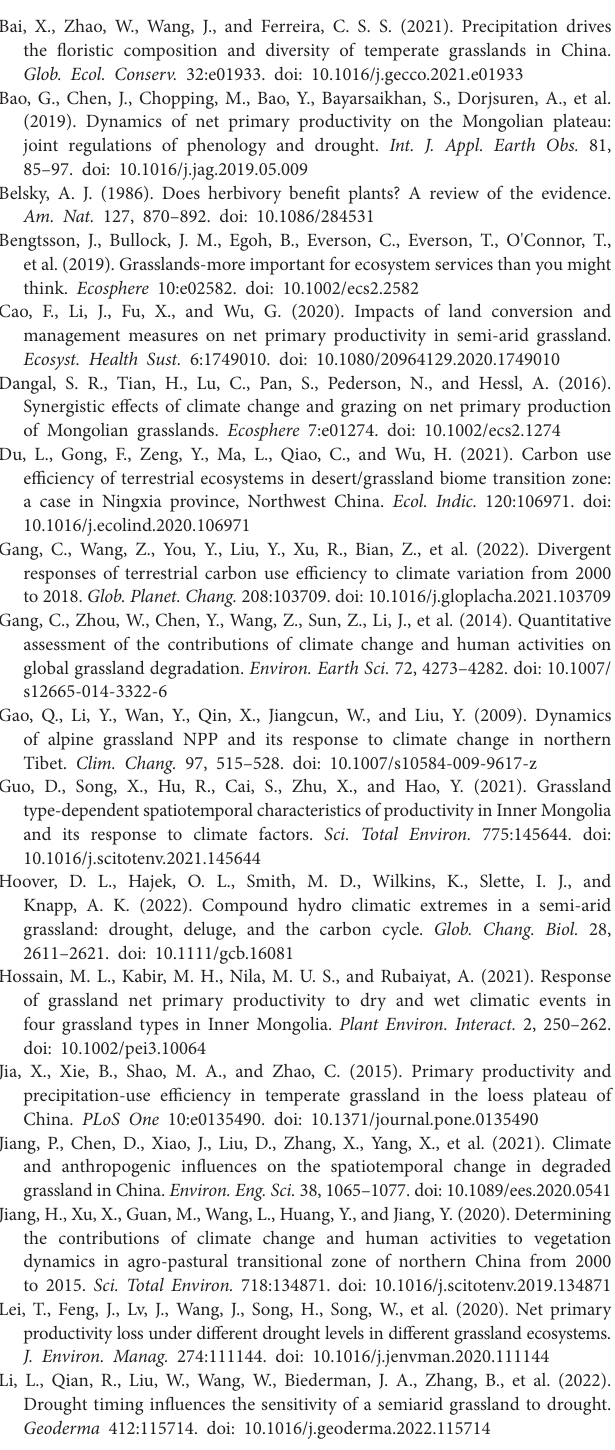
Supplementary Figure 2 | Correlations between annual net primary productivity (NPP) and winter precipitation (A) , winter mean temperature (B) , winter maximum temperature (C) , and winter minimum temperature (D) of temperate grasslands in China during